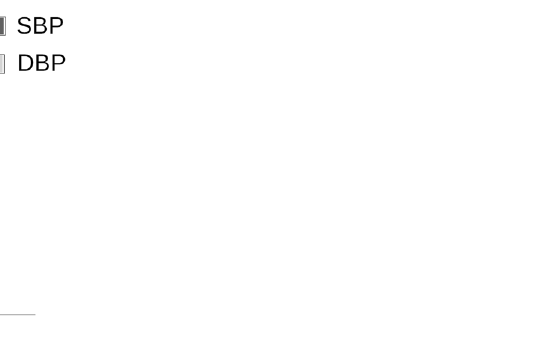
Figure 4. 24-hours systolic (SBP) and diastolic (DBP) blood pressure in diabetic patients at baseline and 12 months after renal denervation; bars show means and whiskers show standard